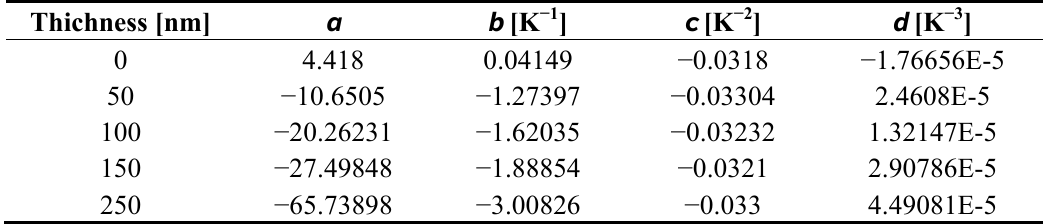
Table 2. Coefficients of the third order polynomial fit for the 5 TFCs in Figure